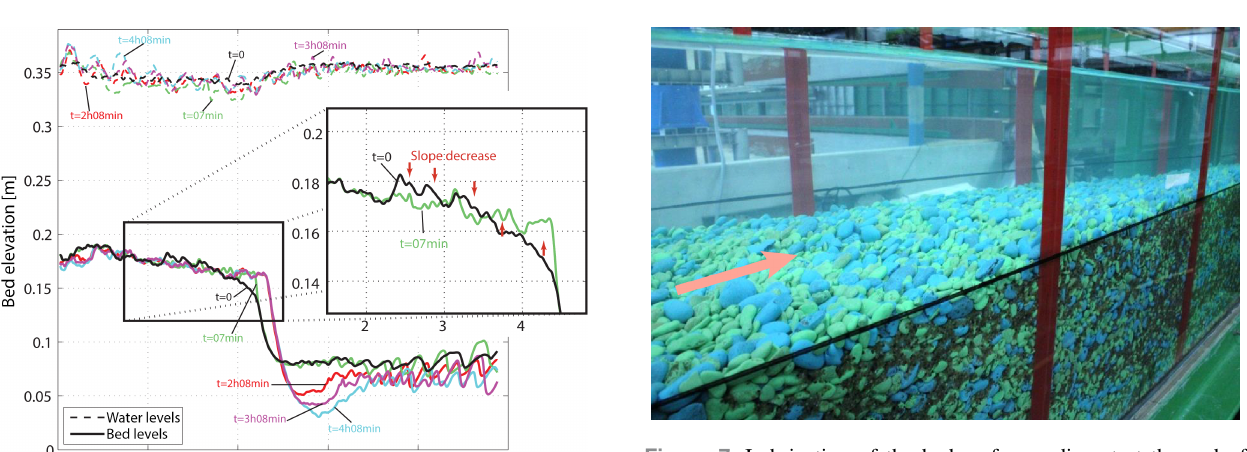
Figure 7. Imbrication of the bed surface sediment at the end of Experiment T 1 . Flow is from left to